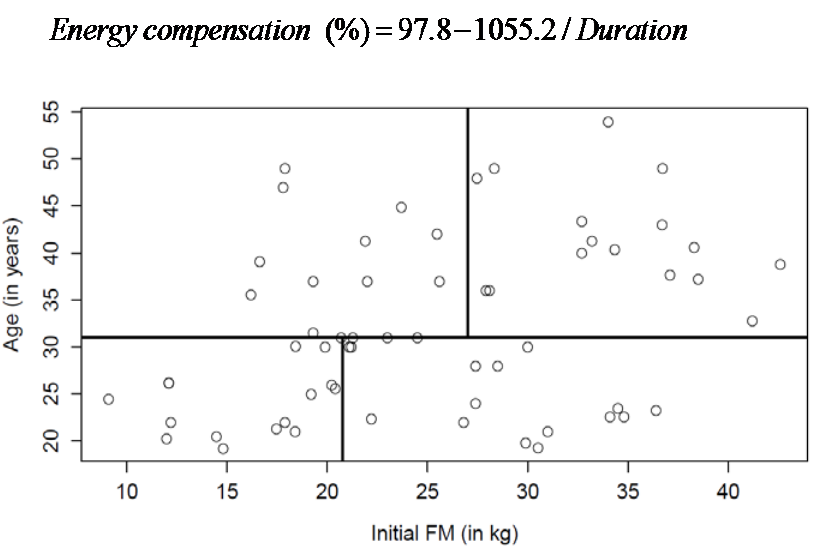
Figure 2. Correlation between age and initial FM. The median of age = 31 years old; the median for initial FM in studies involving younger subjects = 20.8 kg; and the median for older subjects = 27.5 kg. There were n = 15 studies in all groups, except for the group of older subjects with a high initial FM ( n = 16 studies).